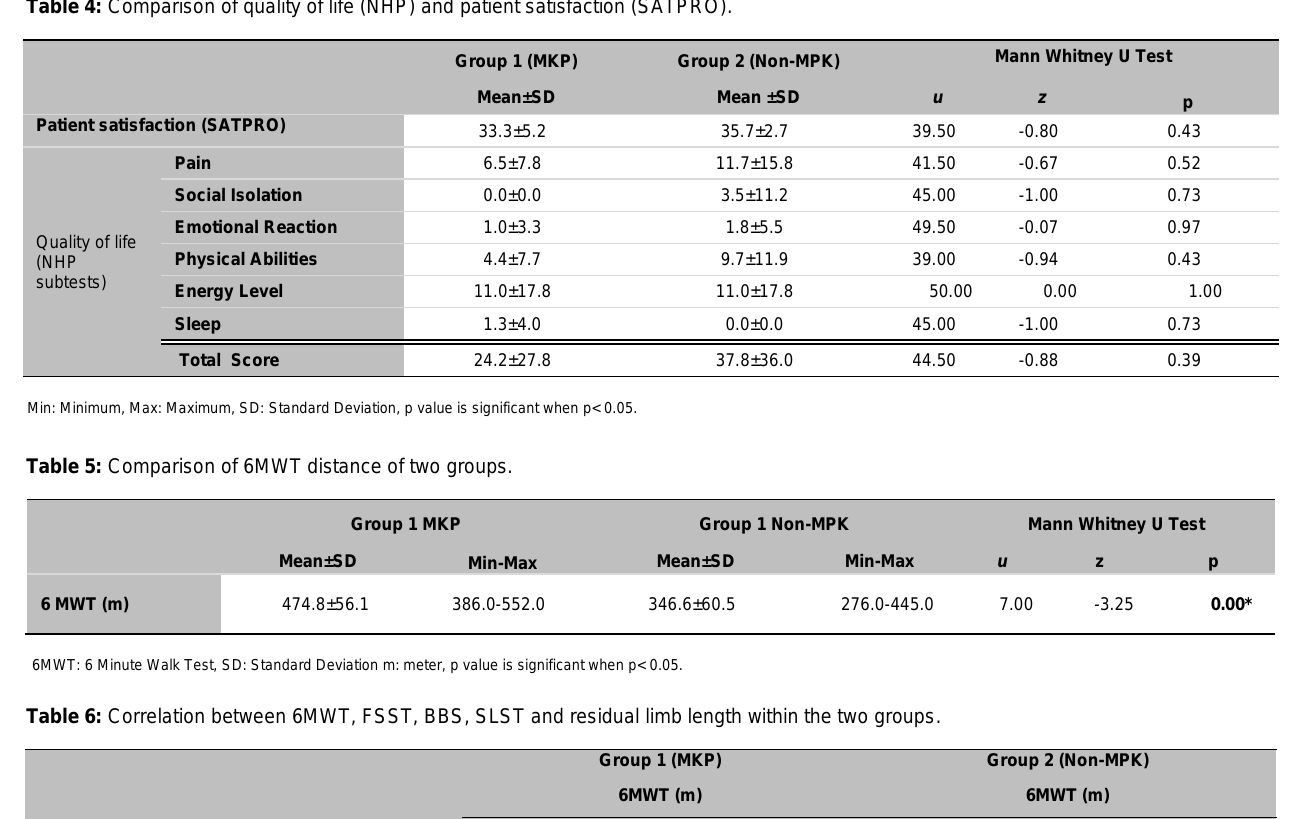
Table 4: Comparison of quality of life (NHP) and patient satisfaction (SATPRO).